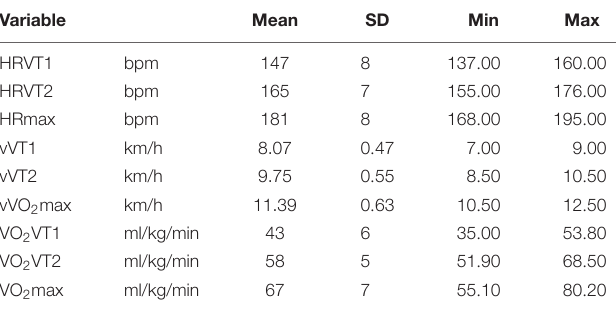
TABLE 2 | Variables measured in laboratory